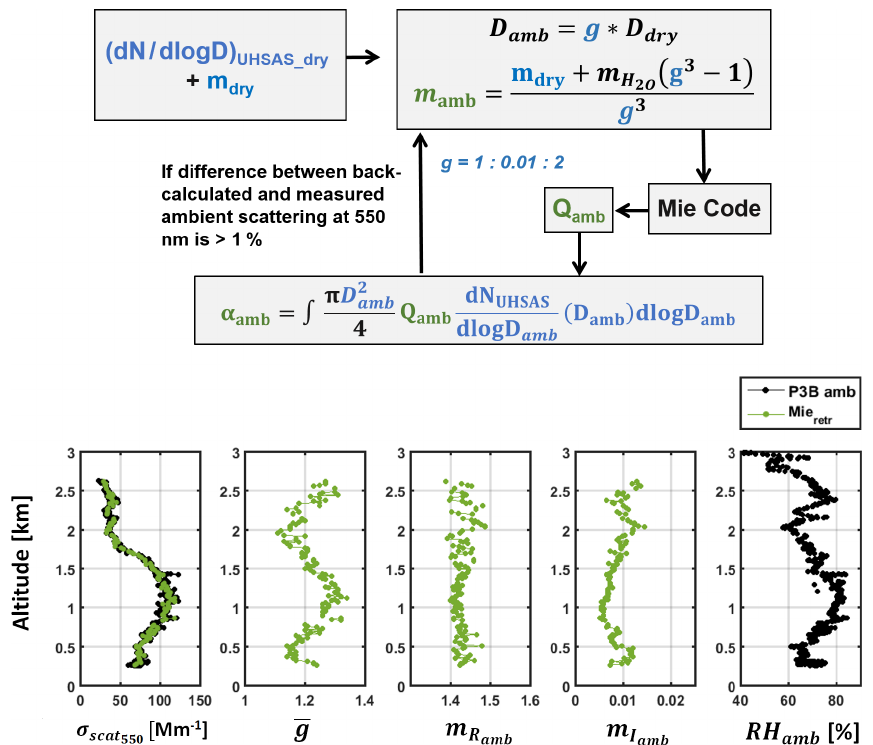
Figure 3. Diagram representation of part II in which effective growth factor g and ambient complex refractive index m amb are retrieved using in situ data. The profiles shown at the bottom of this figure were obtained over the Houston area, on 11 September 2013 between 21:06 and 21:15UTC, during DAQ TX. Measurements are shown in black and retrievals in red in the bottom